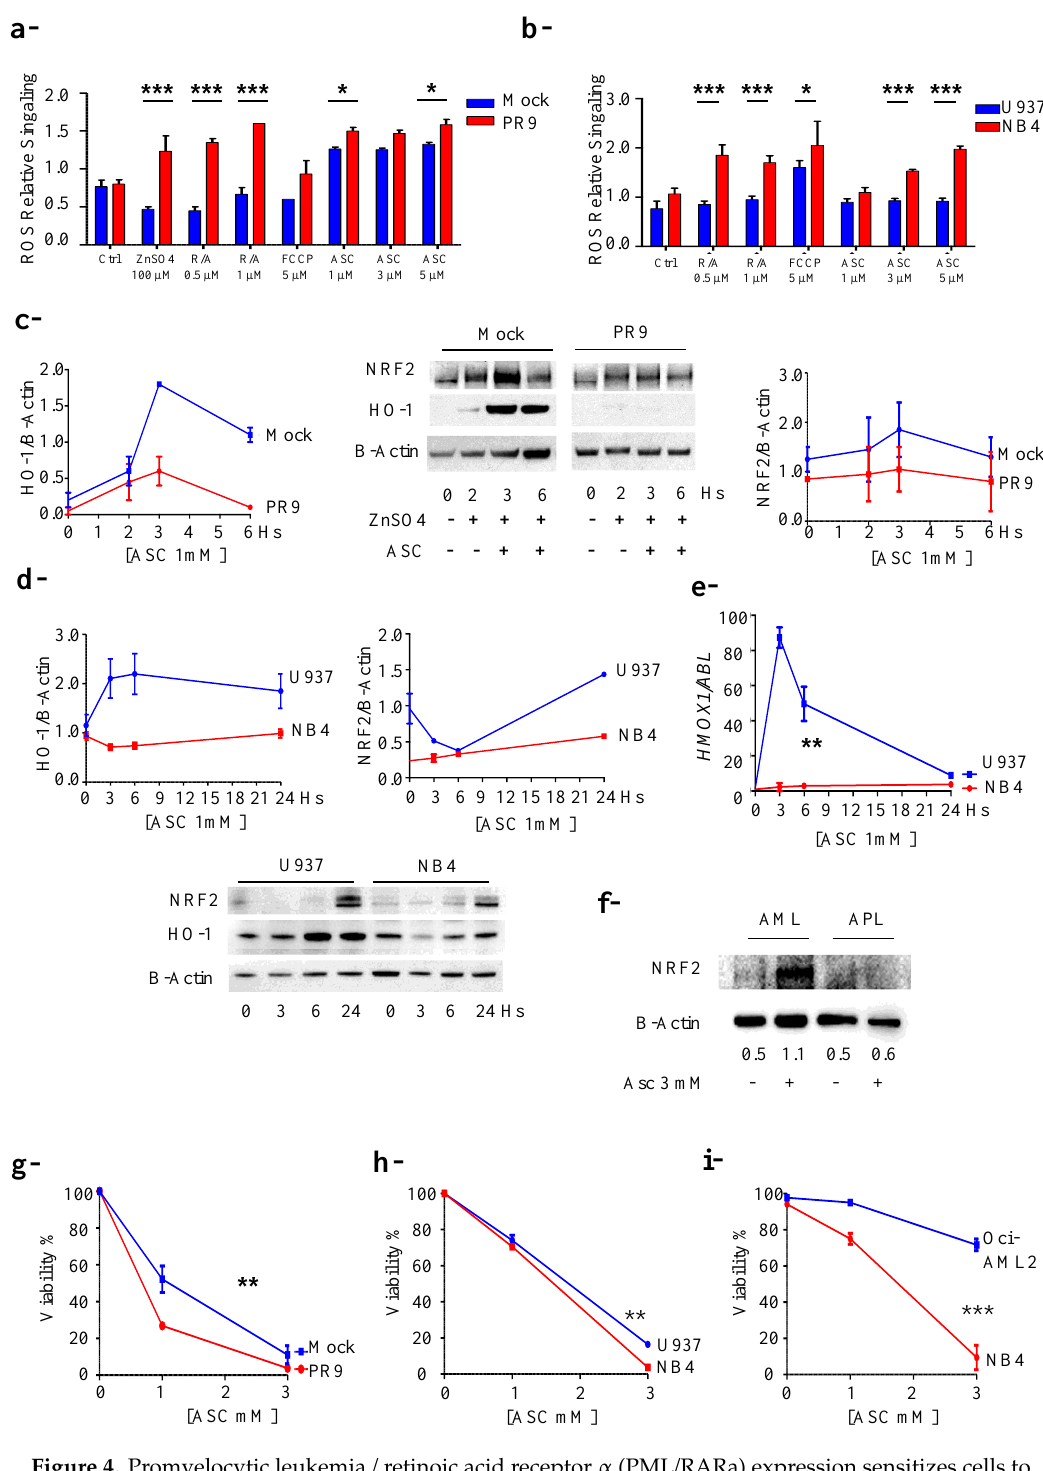
Figure 4. Promyelocytic leukemia / retinoic acid receptor α (PML / RARa) expression sensitizes cells to ascorbate treatment. ( a ) The levels of reactive oxygen species (ROS) content in PR9 and Mock cell lines systems were measured after induction of PML / RARa with ZnSO4. ROS levels were also evaluated after treatment with rotenone / antimycin A, Carbonyl cyanide 4-(trifluoromethoxy)phenylhydrazone (FCCP) and ASC as oxidants. In all systems the presence of PML / RARa induced a significantly higher level of ROS production. ( b ) The level of ROS production was evaluated in NB4, bearing PML / RARa, and U937 cells as control using ZnSO4, Rotenone / Antimicyn A, FCCP and ascorbate (ASC) as